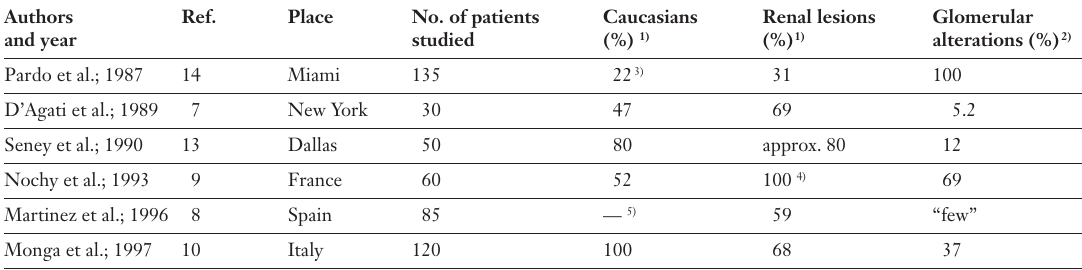
Studies investigating HIV associated renal